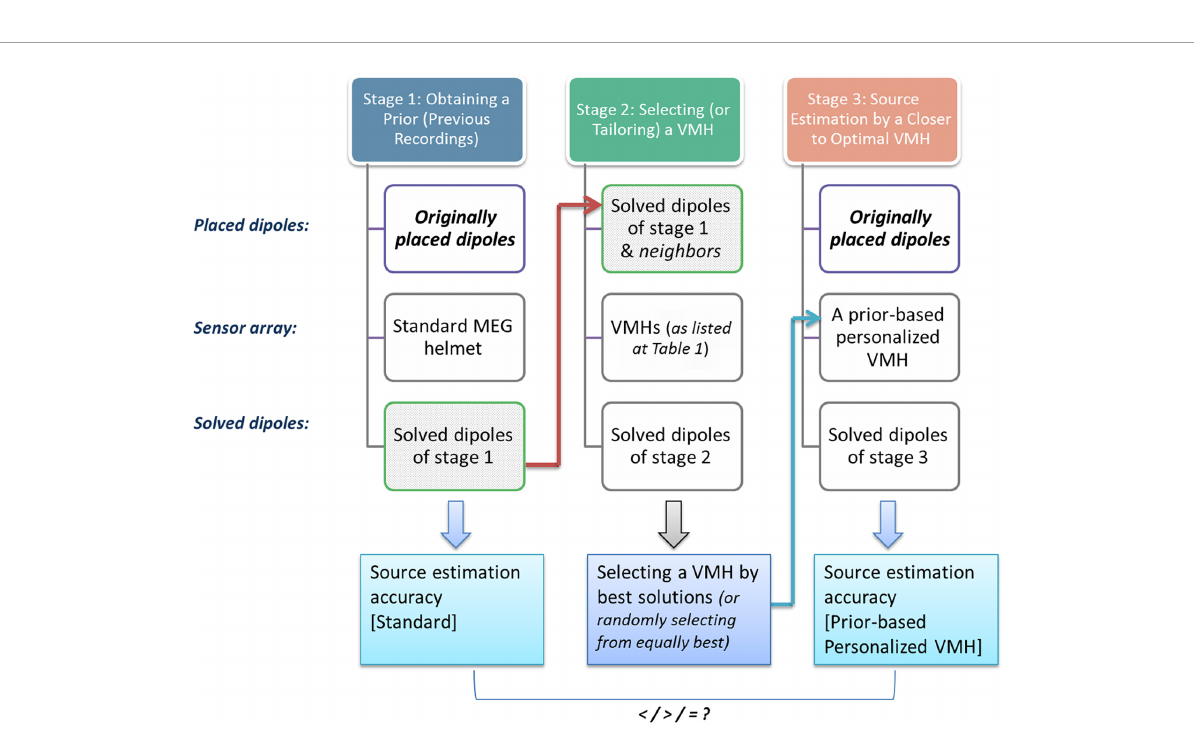
FIGURE6 Constructing a prior-based personalized VMH. A flow chart of the sequence of simulations that were carried out in part III. (stage 1) simulating 1st set of MEG recordings in the standard position of the head inside an MEG helmet, while supposedly actual pair of active neuronal sources are imitated by a placed pair of dipoles; (stage 2) next, the source estimation of stage 1 was set as a prior source distribution in the current stage. These placed prior-based dipoles as well as similar dipoles at neighboring grid points were used to determine the closest to optimal VMH among the examined VMHs (for details, please see Section “Methods: Details of simulations: Part III”) (stage 3) following, the original active sources simulated at stage 1 are now subject to source estimation by the VMH that was chosen in the 2nd stage, and the results are compared to the source estimations of the same original sources by the standard MEG helmet. This is done in order to examine whether the chosen VMH of stage 2 advances the source estimation accuracy relative to the actual neuronal